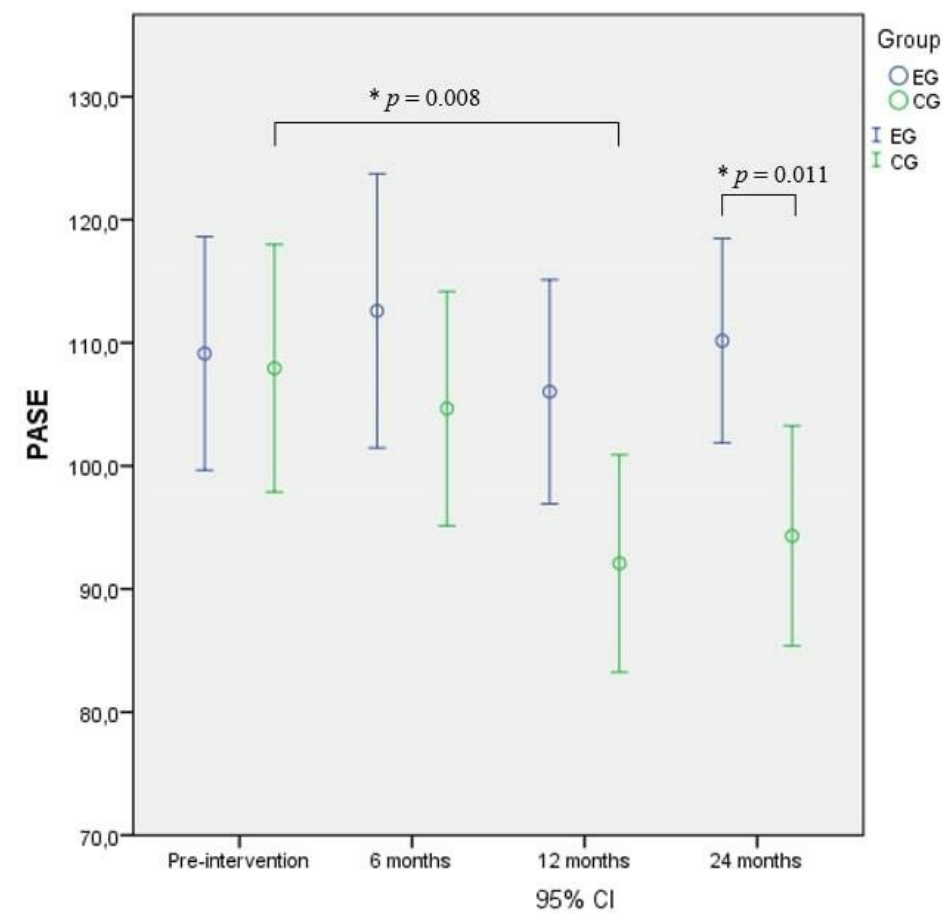
Figure 4. Physical activity scale for the elderly (PASE) comparison between and within groups. * = Significant difference. Table 2. Results obtained by the two groups in the three tests.